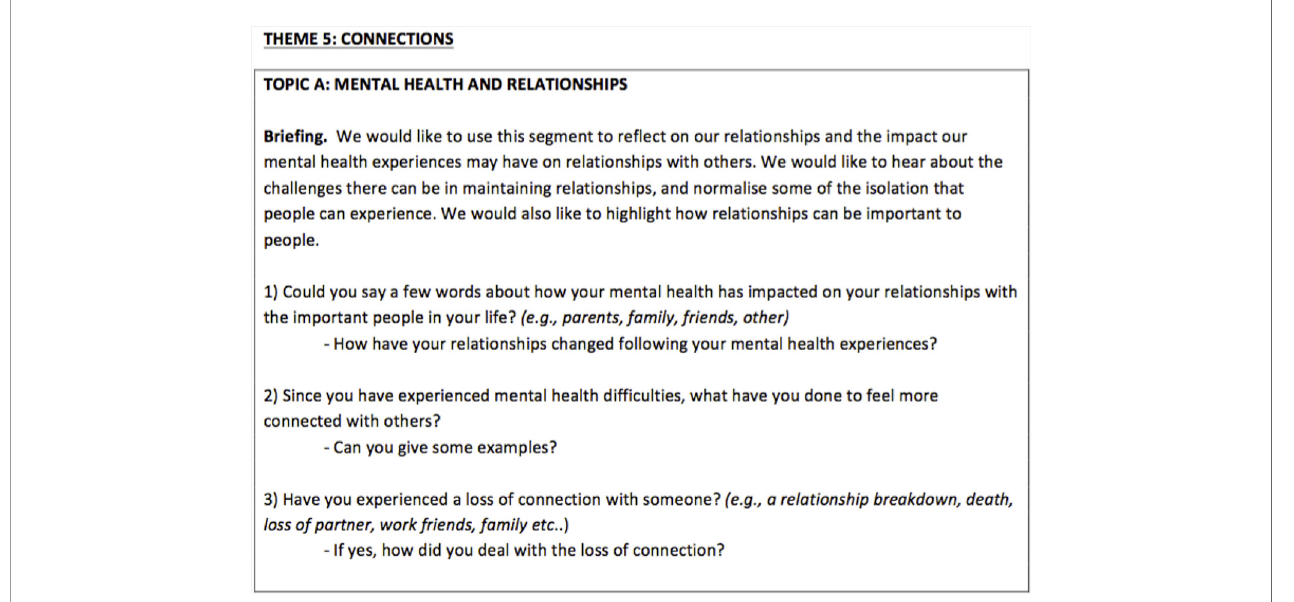
FIGURE 2 | Example of the lived experience fi lming interview